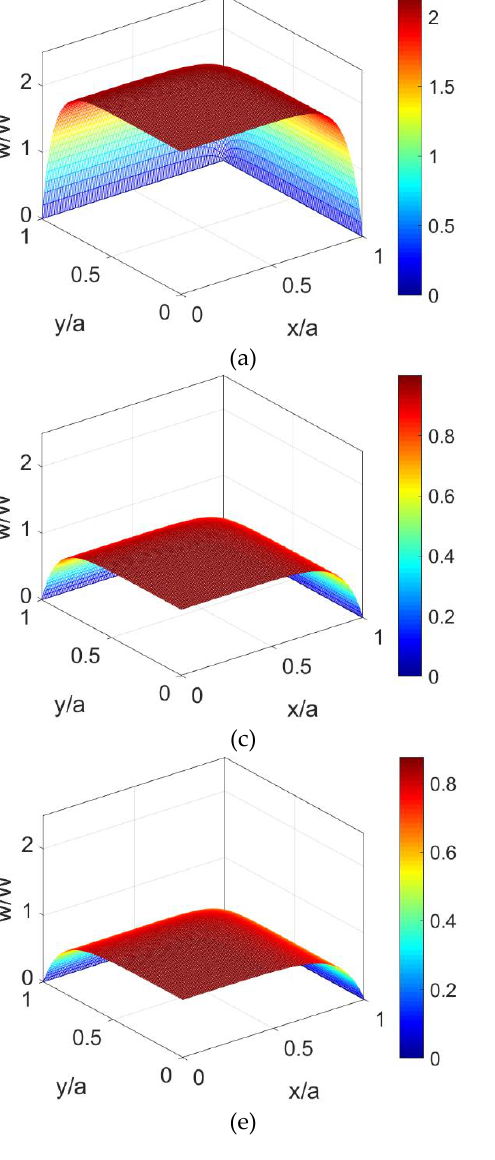
Figure 4. The dimensionless temperature distributions of shear thinning fluid, Newtonian fluid, and shear thickening fluid for different Joule heating parameter when nanoparticle volume fraction is ϕ = 0: ( a ) n = 0.8, S = 0; ( b ) n = 0.8, S = 3; ( c ) n = 1.0, S = 0; ( d ) n = 1.0, S = 3; ( e ) n = 1.2, S = 0; ( f ) n = 1.2, S = 3. To observe the influence of volume fraction of nanoparticles on the heat transfer characteristics, the temperature distributions are evaluated in Figure 5 when the nanoparticle volume fraction ϕ is increased to 0.06, and other parameters keep unchanged. The corresponding temperature profiles at